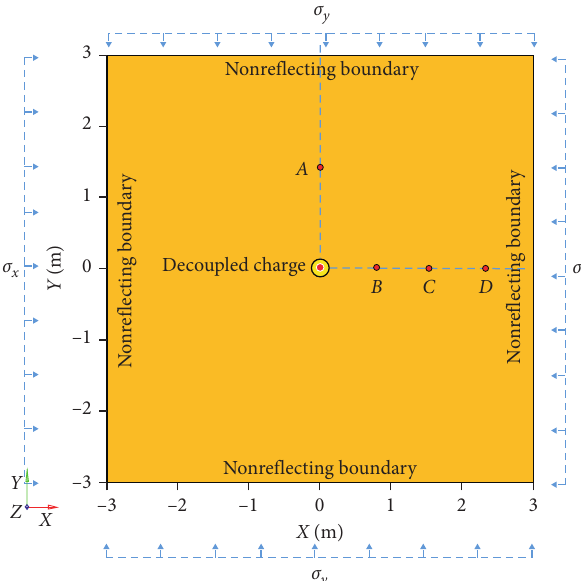
Figure 6: Layout of numerical model and boundary